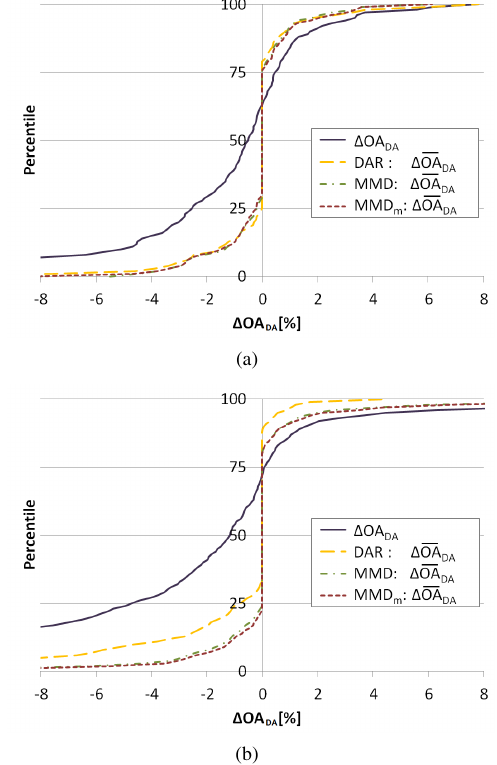
Figure 5: Percentile plots of ∆OA DA after the negative transfer prediction using three metrics for Vaihingen (a) and Potsdam (b) and of the results without that prediction ( ∆OA DA